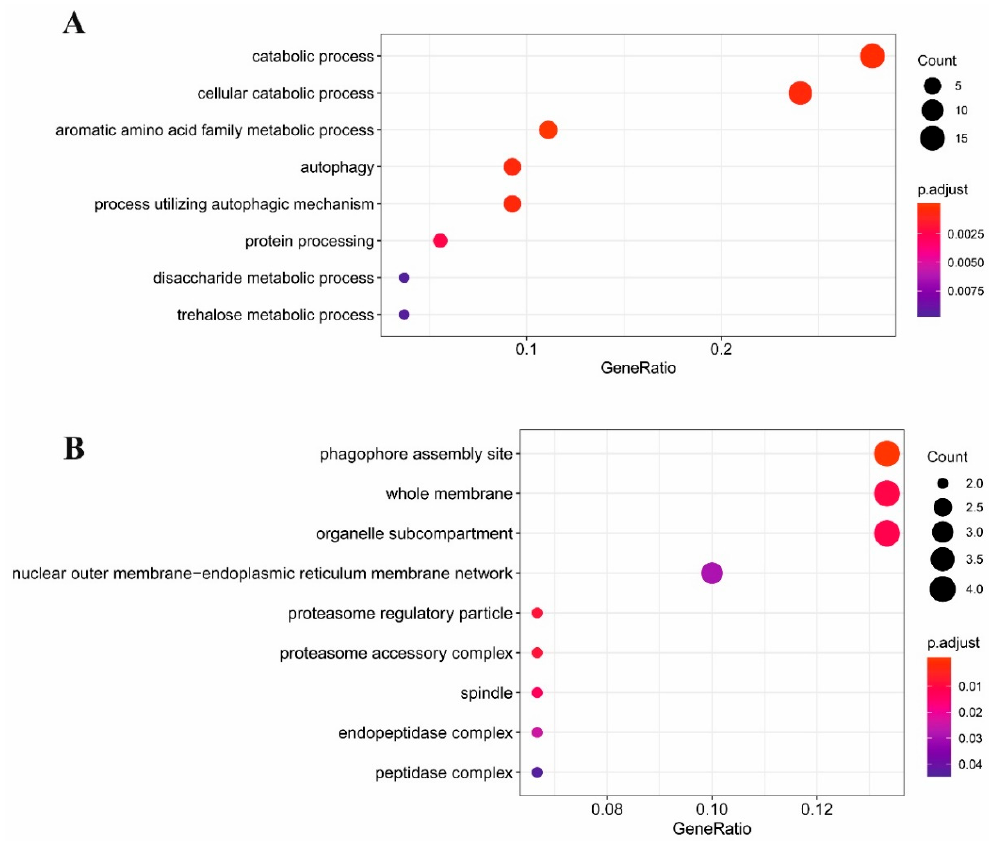
Figure 2. Results of GO GSEA of P. rubens downregulated genes for different GO domains’ ( A ) biological processes and ( B ) cellular components. No GO molecular functions were detected. The significance, as well as the rate of involvement of downregulated genes, are marked with the same colors and shapes.